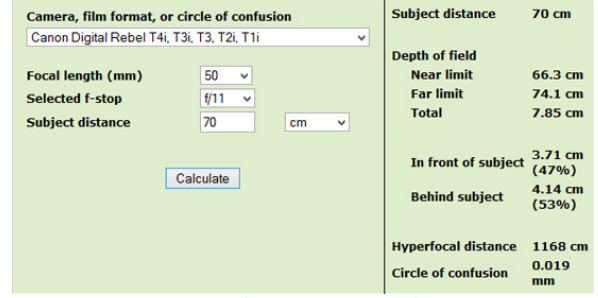
Fig. 6 Depth of Field parameters for 600D.